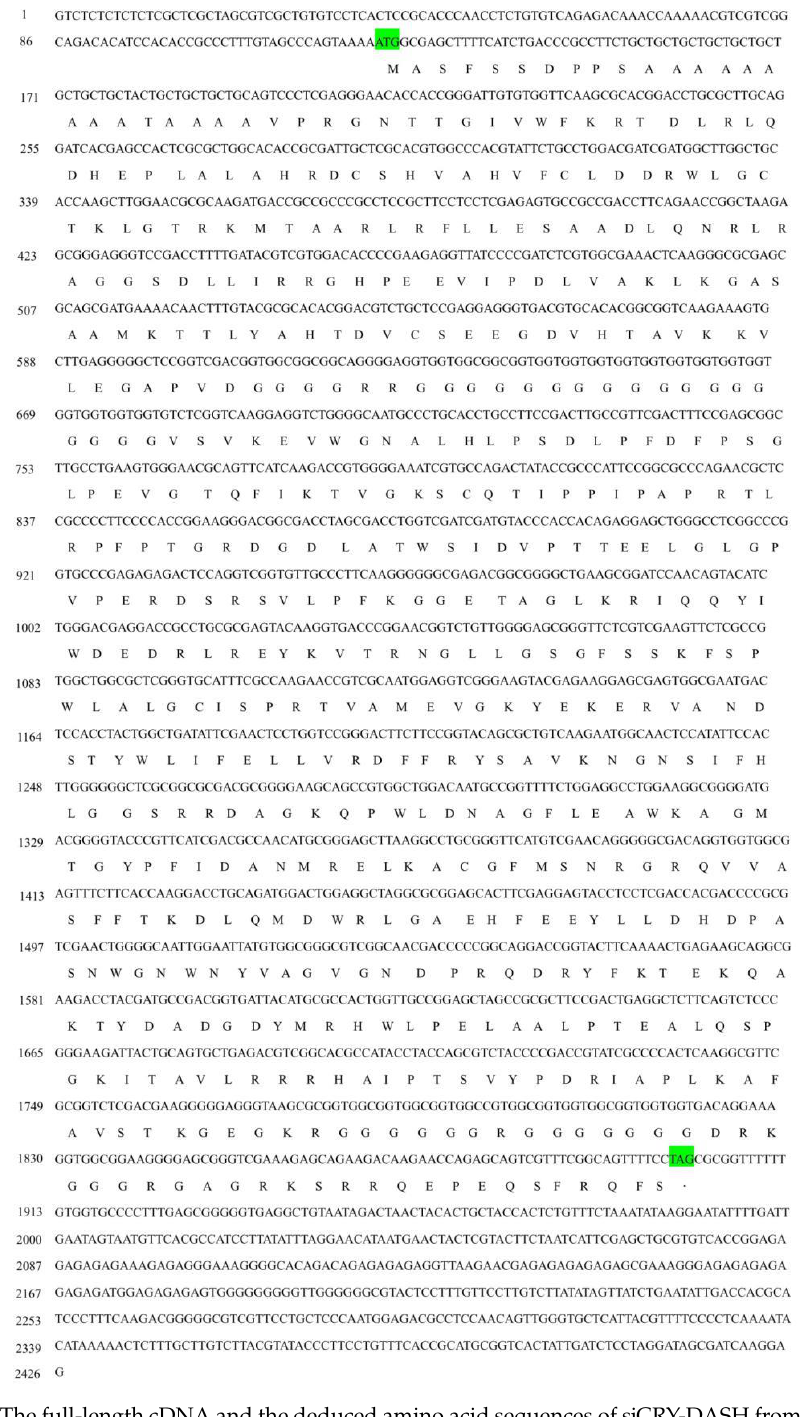
Figure 1. The full-length cDNA and the deduced amino acid sequences of sjCRY-DASH from Saccharina japonica . The letters in green indicate the start codon (ATG) and stop codon (TAG).